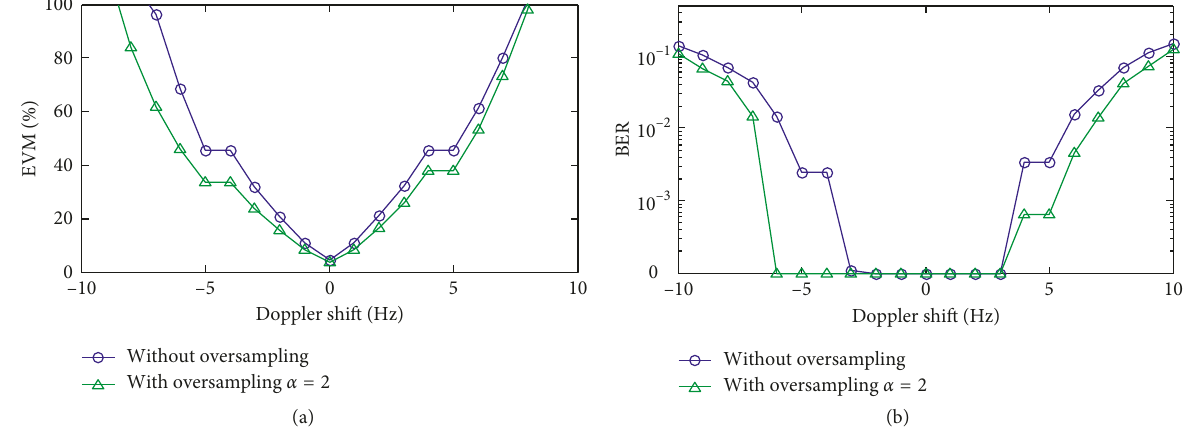
Figure 4: Tolerance for Doppler estimation errors. (a) EVM and (b) BER.